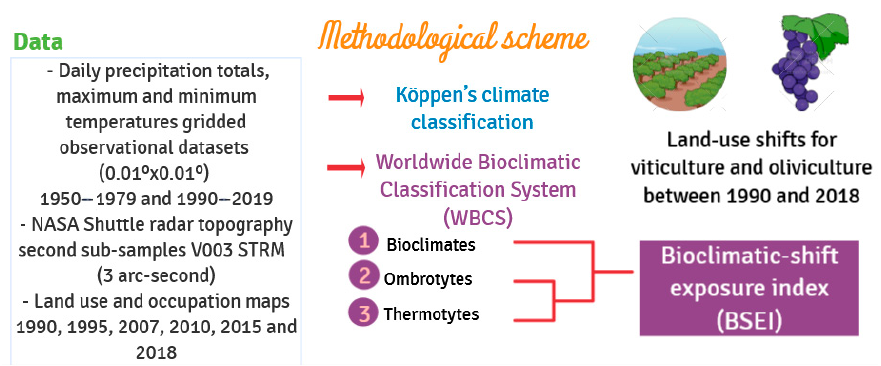
Figure 2. Methodological schematics of this study.